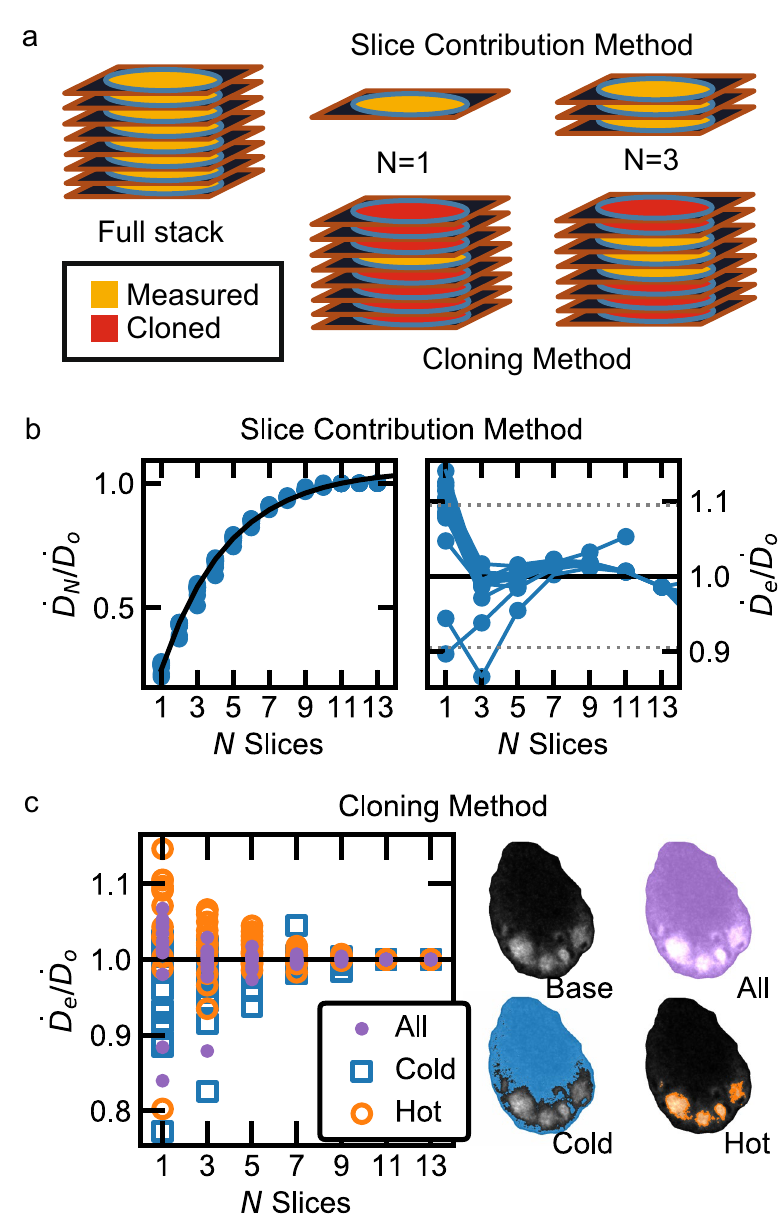
Figure 7. Slice minimization analysis. ( a ) Cartoon schematics showing slice contribution and cloning methods for approximating dose rates using limited data. ( b ) (Left) Cumulative contribution of N slices, ˙ D N , towards central-slice dose rate ˙ D 0 . An exponential fit (black line, χ 2 /ν = 1.73) provided a method to scale up a low-slice dose rate image. (Right) Evaluation of the slice contribution method by comparing ˙ D e to ˙ D 0 . The mean deviation of ˙ D e from ˙ D 0 (14 biopsies) using once slice was 9.5% (gray dashed lines). ( c ) (Left) Evaluation of the cloning method in hot and cold data subsets. (Right) Mosaic of lymph node slices highlighted to show evaluated regions. The mean deviation of single-slice ˙ D e from ˙ D 0 (14 biopsies) was 4.8%, but no full-slice data were otherwise required. High density of hot data points above, and of cold data points below, the ˙ D e / ˙ D 0 = 1 line reflects overemphasis of features from the measured